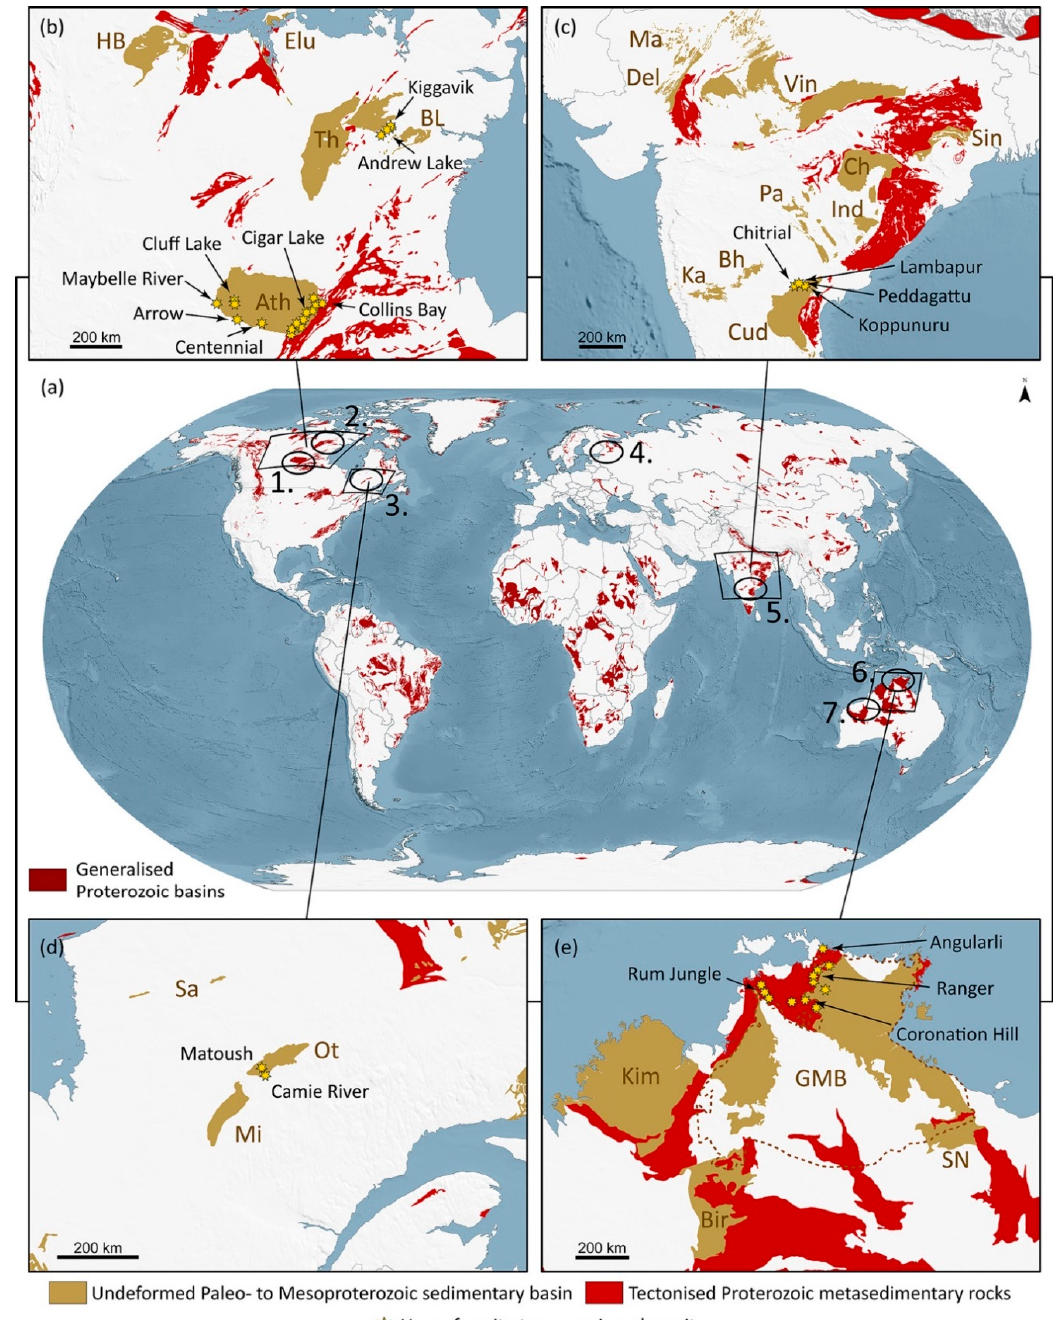
Figure 1. Proterozoic basins of the world. Undeformed or weakly deformed Paleo- and Mesoproterozoic intracratonic sedimentary basins are differentiated from tectonised Proterozoic metasedimentary strata in each of the insert maps. ( a ) Generalised global distribution of Proterozoic (meta-) sedimentary rocks. Regions hosting significant unconformity-type uranium deposits are indicated by numbered ellipses. 1: Athabasca Basin, Canada; 2: Thelon Basin, Canada, 3: Otish, Basin, Canada; 4: Pasha-Ladoga Basin, Russia, 5: Cuddapah Basin, India, 6: McArthur Basin/Pine Creek Inlier, Australia; 7: Rudall Complex, Australia. ( b ) Paleo- to Mesoproterozoic basins of the western Canadian Shield that contain significant unconformity-type uranium deposits, or that have the potential to host them. HB = Hornby Bay Basin, Elu = Elu Basin, Th = Thelon Basin, BL = Baxter Lake Basin, Ath = Athabasca Basin. ( c ) Meso- to Neoproterozoic intracratonic basins in India with potential to host unconformity-type uranium deposits. The Cuddapah Basin, straddling the border of